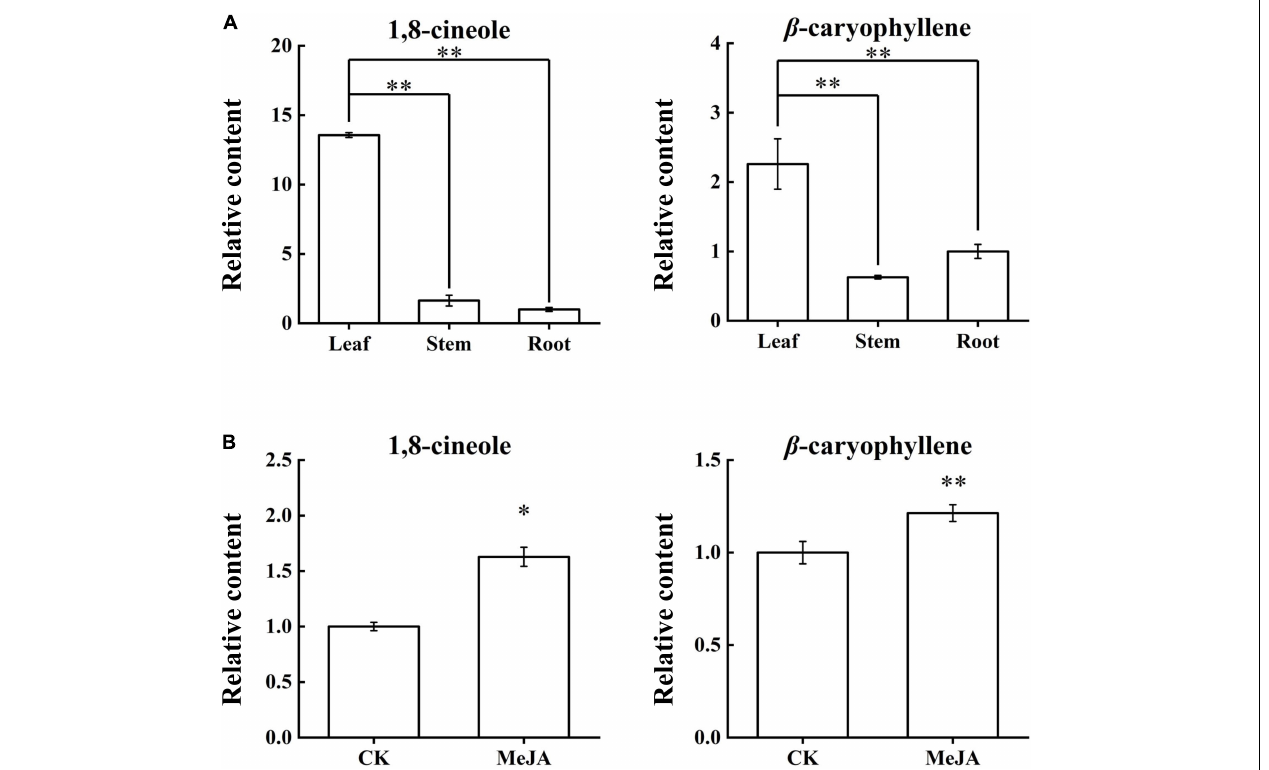
FIGURE 5 | Content changes of 1,8-cineole and β -caryophyllene in the LSR group and the MeJA group. (A) Relative contents of 1,8-cineole and β -caryophyllene in the LSR group. (B) Relative contents of 1,8-cineole and β -caryophyllene in the MeJA group. The values represent means ± SD ( n = 3). ∗ Means p -value < 0.05, and ∗∗ means p -value <